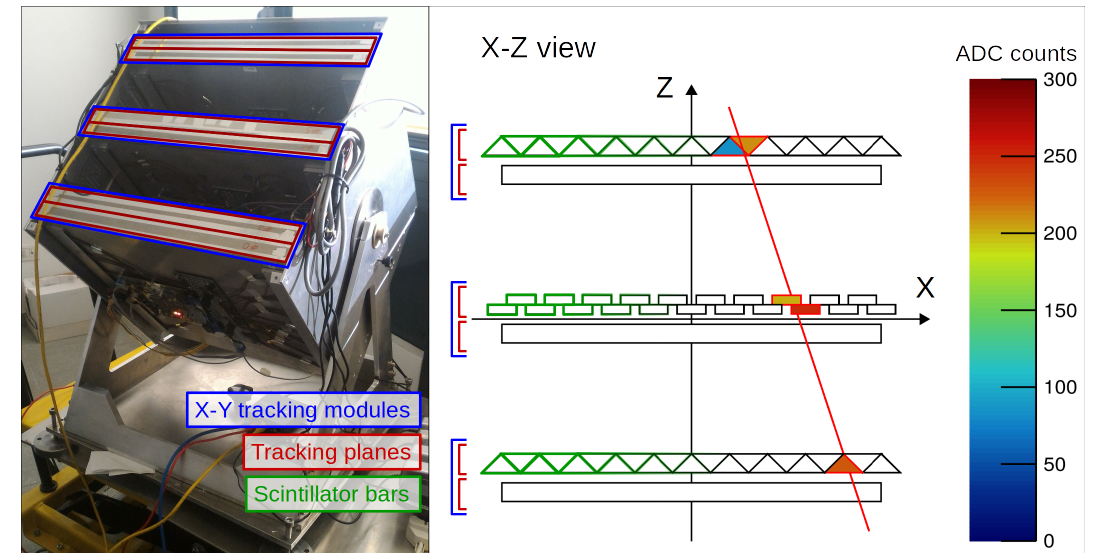
Figure 1. On the left : a picture of the MIMA detector showing its structure. One can see the three X - Y tracking modules, the rotating platform, and part of the electronics. On the right : an example of a reconstructed track in the X - Z view. The type of bars and their arrangement is shown for this view, and the color map on the right indicates the intensity of the signal detected on the single